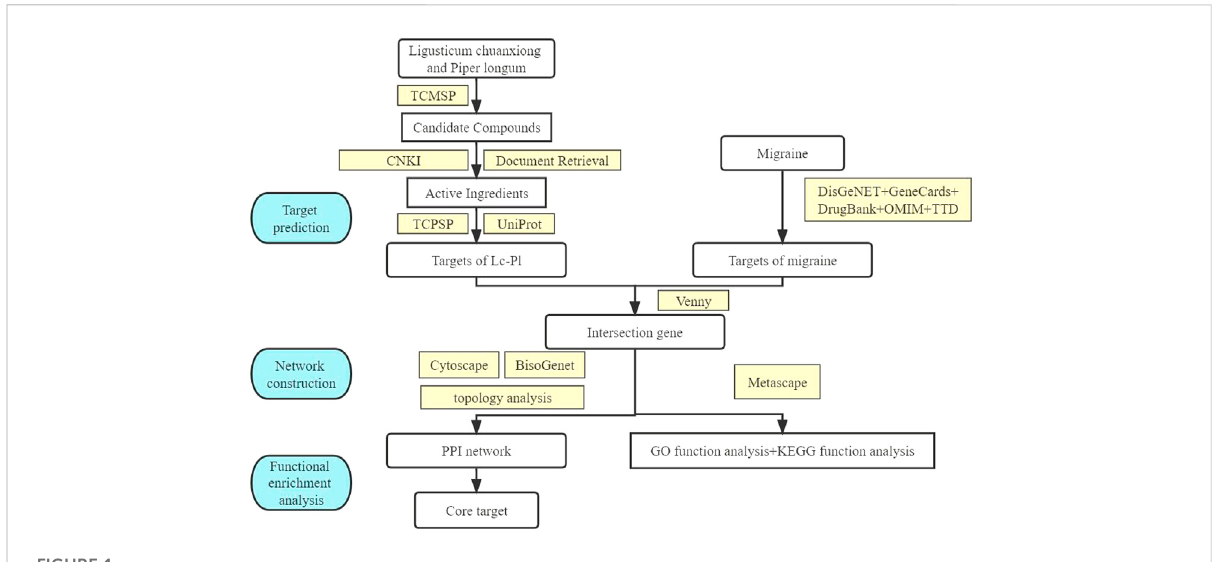
FIGURE 1 A fl owchart of the study